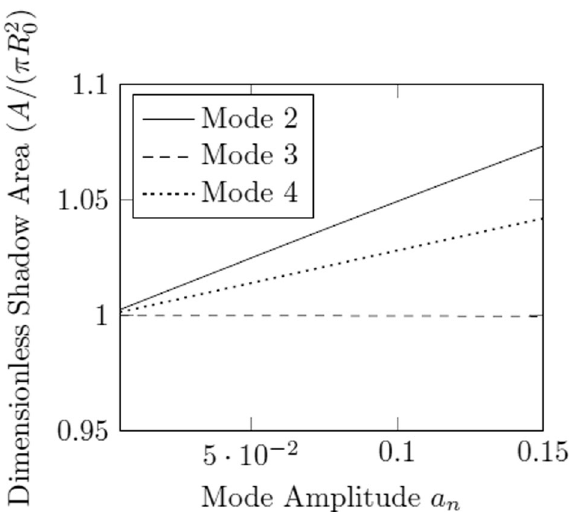
Fig. 7 Comparison of shadow area change for modes 2, 3, and 4 as a function of deformation amplitude. The dimensionless Þ ) are calculated using the analytical spherical shadow areas ( A = ð π R 2 0 harmonics of the droplet with superimposed mode 2, mode 3, mode 4 functions at varying amplitudes a n with volume constrained π R 3 to 4 0 3